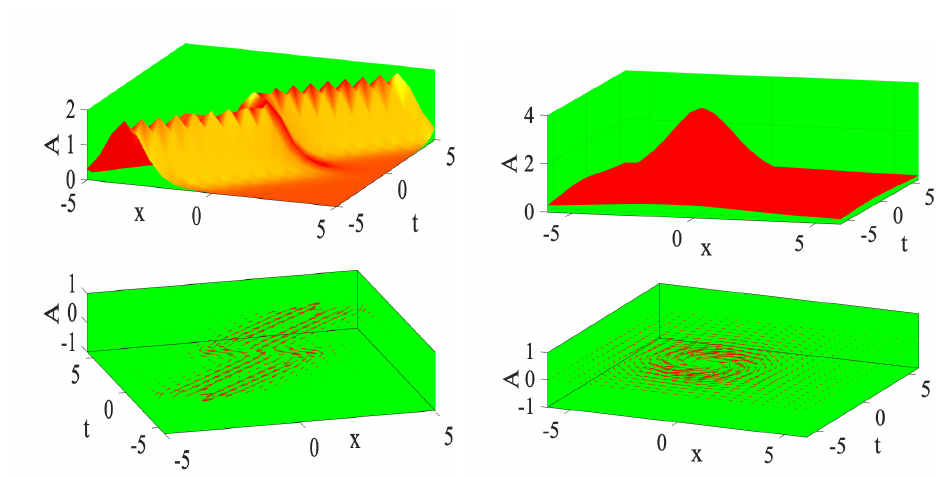
Figure 1. The wave expressed by solution (22) ( Left ) and a lump-type vortex expressed by solu- tion (25) ( Right ) with parameters chosen as: k = 1, α = 0.2, γ = 0.25, δ = 4, µ = 3, a 2 = 1, a 1 = 1, a 0 = 5, b 2 = − 1, b 1 = − 3, b 0 = 0 and d =